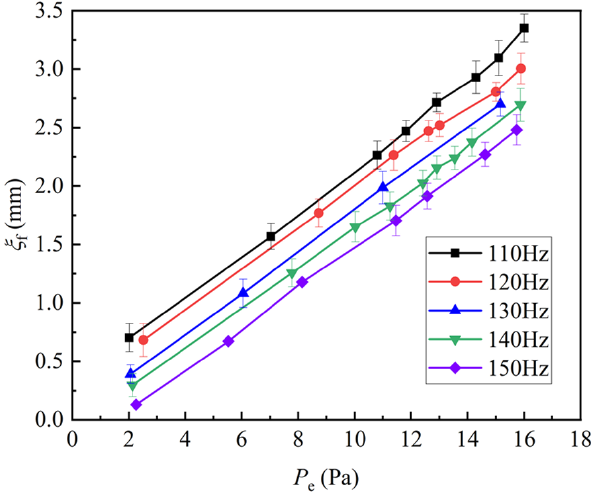
ξ in sound fields of different frequencies and intensi- f